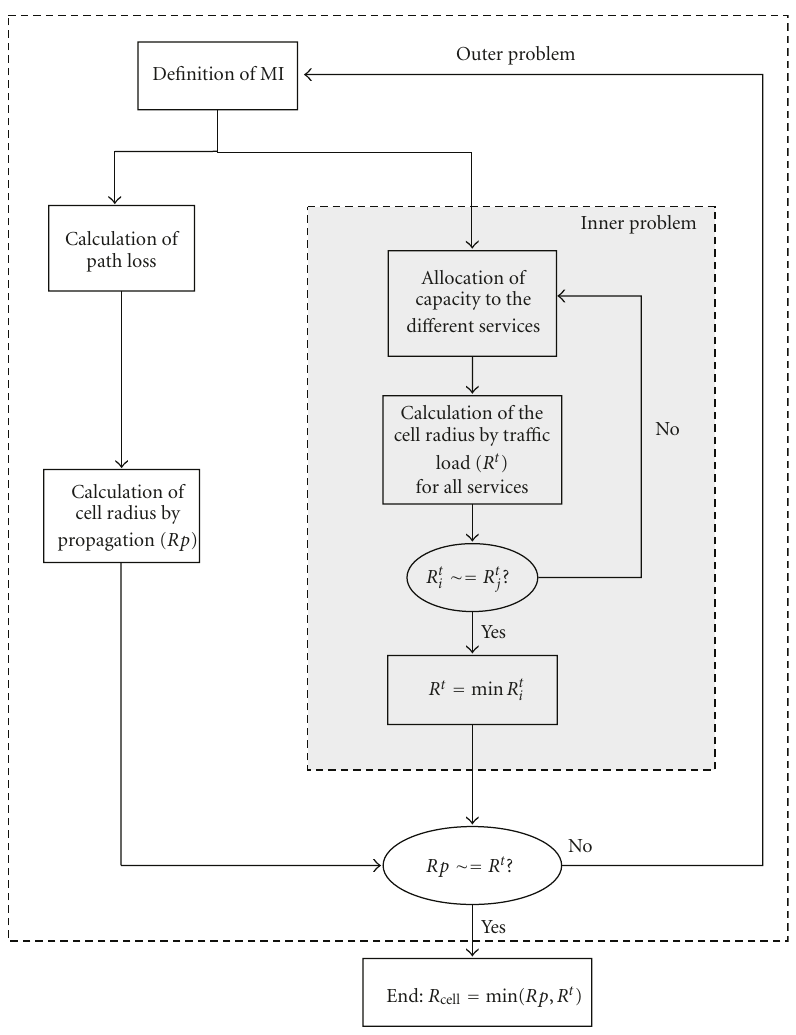
Figure 3: Inner and outer WCDMA problems in dimensioning